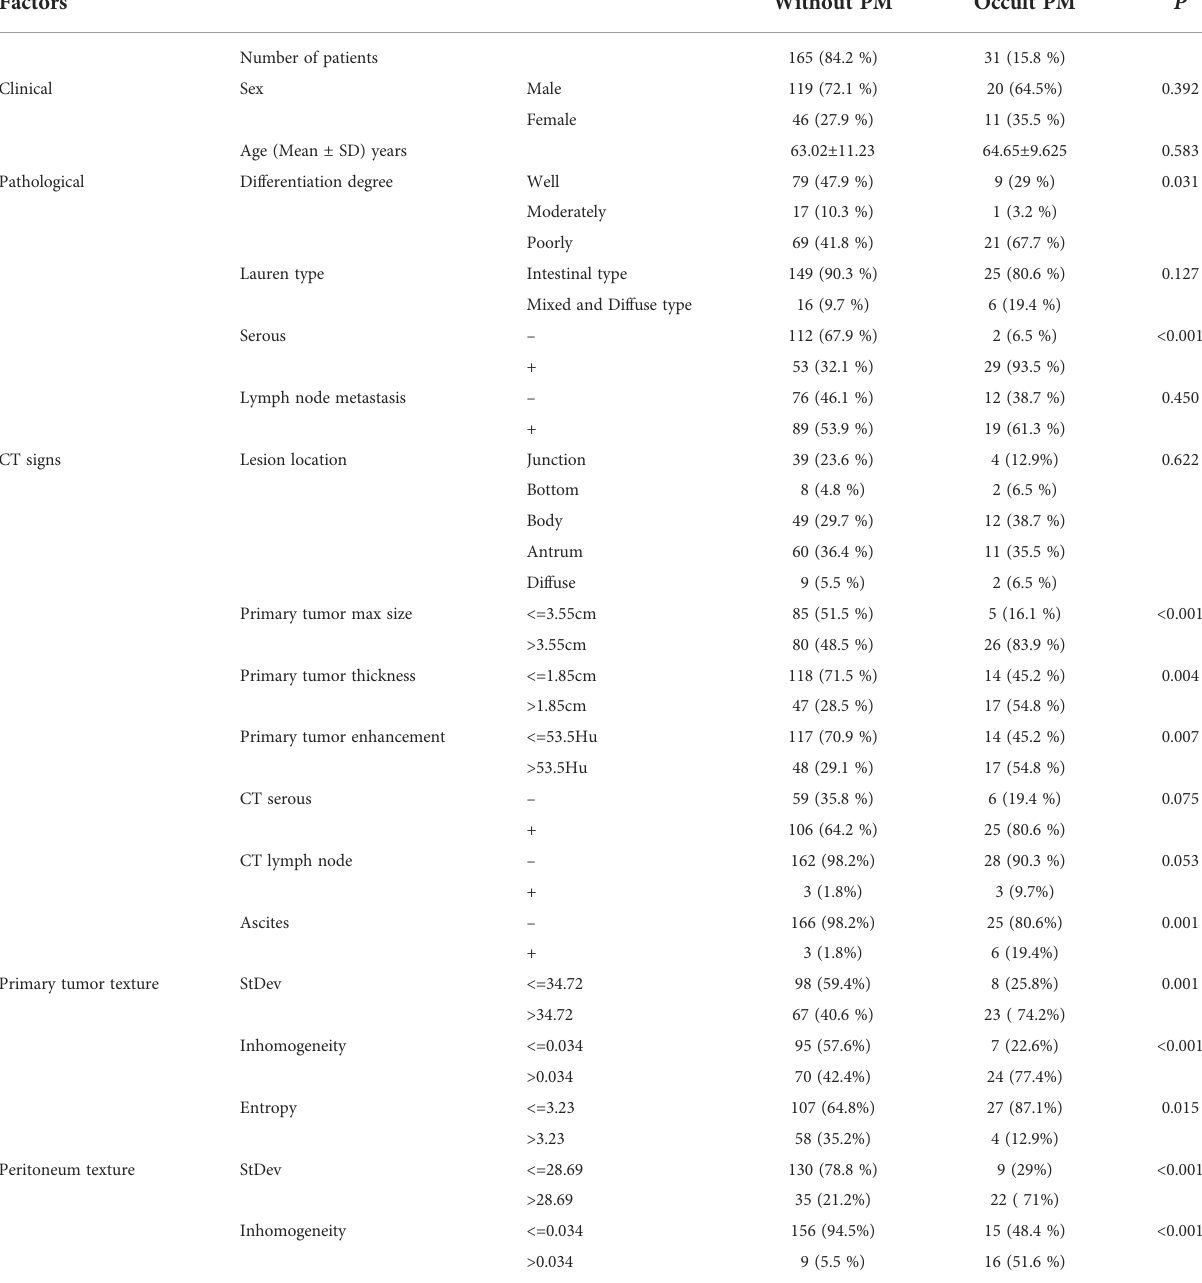
TABLE 1 Univariate analysis of the clinical, pathological, and texture characteristics of gastric cancer patients.